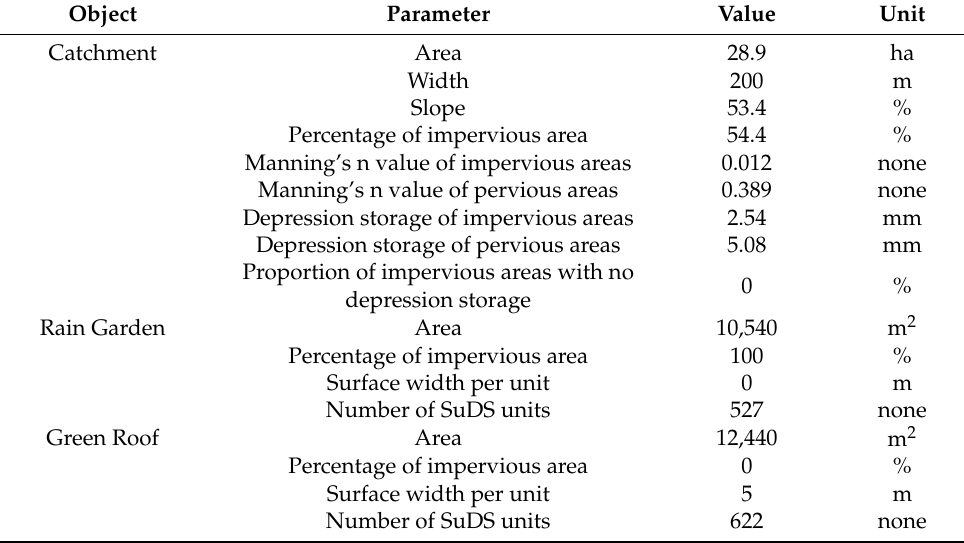
Table 2. Parameter settings of the hypothetical subcatchment in the SWMM model.